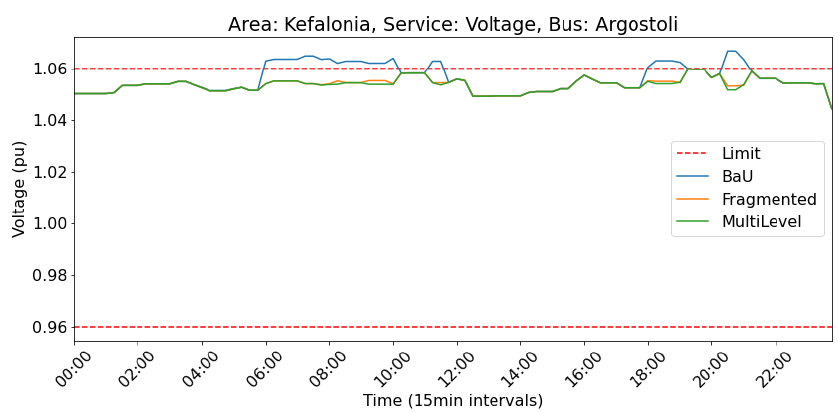
Figure 7. Example of a daily voltage variation at Argostoli substation during the beginning of sum-